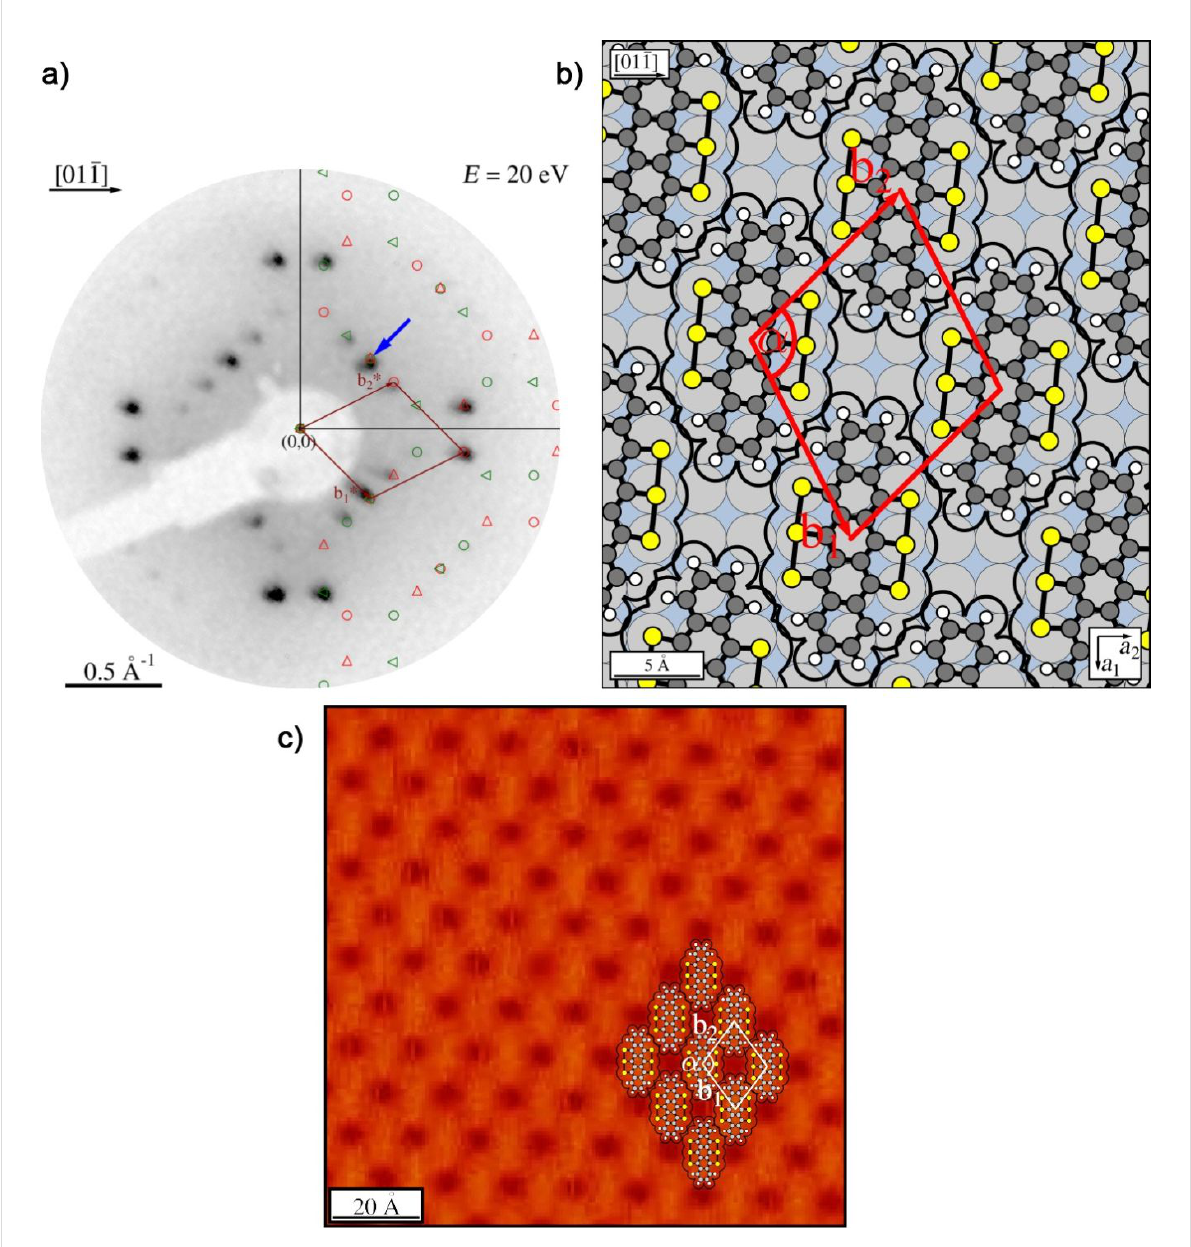
Figure 2: Relaxed superstructure of HTPEN on Ag(100). (a) LEED pattern at an electron energy of 20 eV. A simulated diffraction pattern is overlaid on its right half. Triangles and circles represent respective domains related by mirror symmetry; green and red spots correspond to domains rotated by 90° with respect to each other. The two overlapping spots labeled by the blue arrow are indicative for the commensurability of the superstructure. The black lines indicate the orientation of the Ag(100) substrate and aid in the identification of the symmetry of the LEED pattern. The lengths in recip- rocal space are defined by k = 2 π / λ , with λ denoting the electron wavelength. (b) Hard-sphere model of HTPEN on Ag(100). (c) Fourier-filtered, drift- corrected and contrast-enhanced STM image. The slow scanning direction is horizontal ( U b = − 2.0 V; I t = 75 pA). For the color coding of the atoms compare to the formulas in Figure